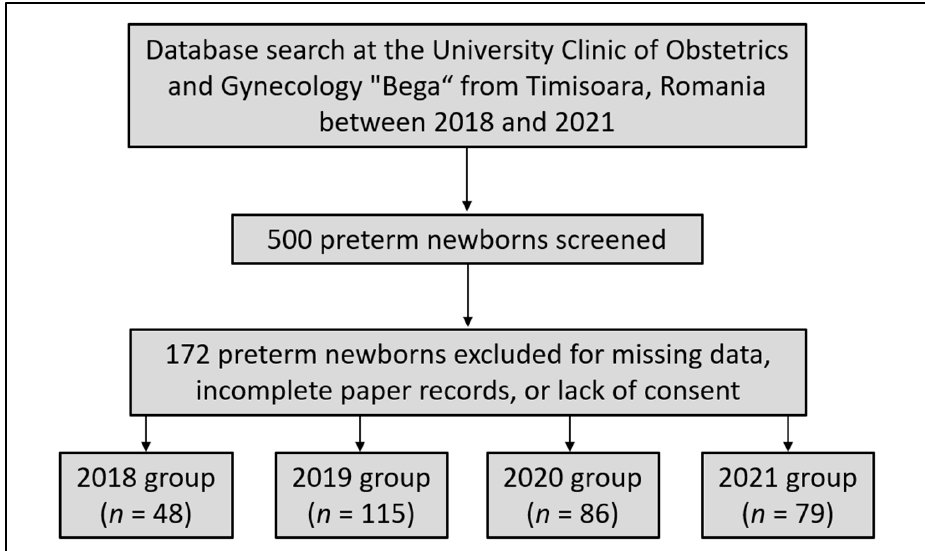
Figure 1. Flowchart displaying preterm newborns included in the current study.